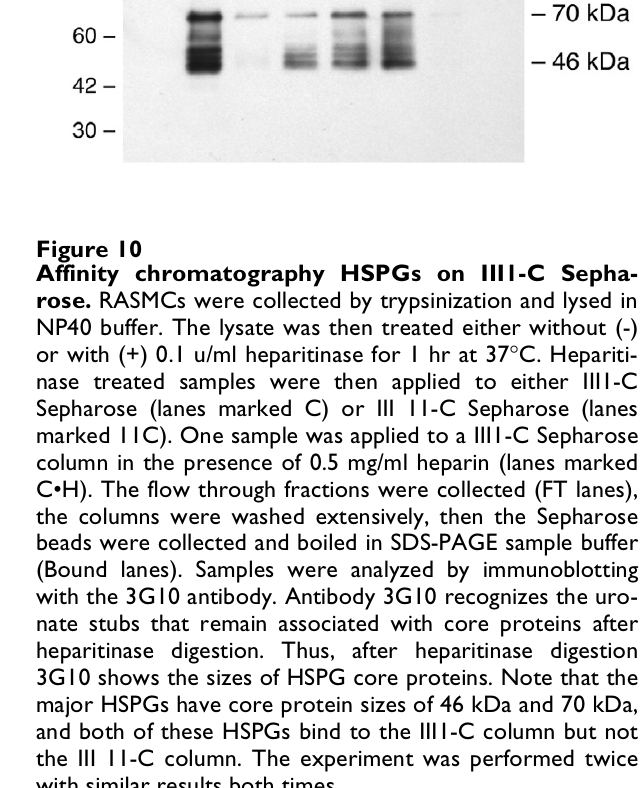
cell adhesion and ERK activation by III1-C. For example, various β 1 integrin blocking agents inhibit cell attach- ment to III1-C and ERK activation by III1-C. In addition, inhibition by heparin, heparan-sulfate, and heparitinase, but not by chondroitin sulfates or chondroitinase ABC all point to the importance of HSPGs as receptors. Affinity chromatography with 125 I surface labeled proteins re- sulted in the binding of proteins of the appropriate sizes of β 1 integrins to both FN and III1-C columns. Moreover, affinity chromatography with 35 SO 4 -labeled cells sug- gests that HSPGs with core protein sizes of 46 kDa and 70 kDa serve as III1-C receptors. Taken together, these results indicate that the first type III repeat of fibronectin can serve as a cell binding domain and that both in- tegrins and cell surface HSPGs function as receptors for this type III repeat.